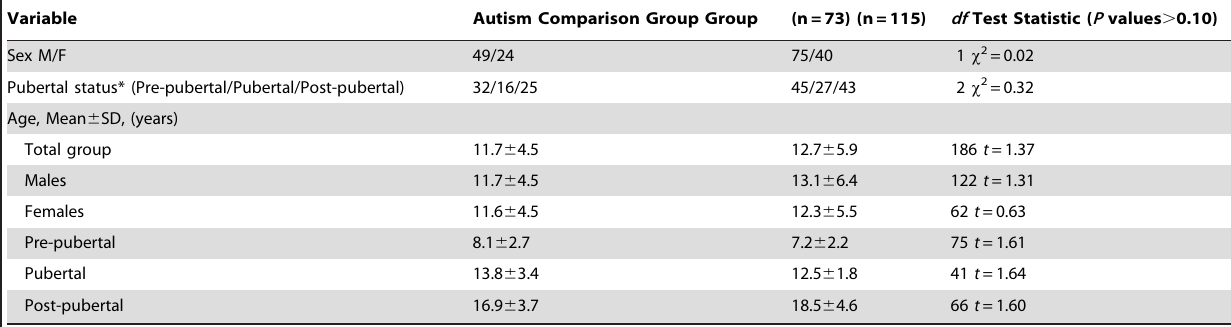
Table 2. Demographic Characteristics of Study